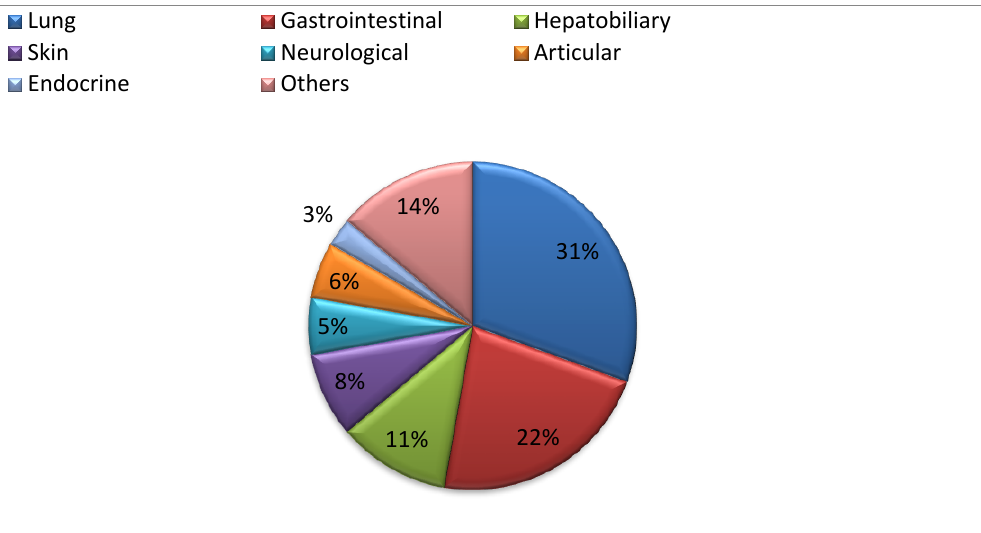
Figure 1. Type and incidence of Grade 3 – 4 irAEs. Grade 3 – 4 irAEs occurring in the series of 201 consecutive patients receiving ICI from 1 January 2016 to 31 December 2019 are summarized in a pie chart, showing that the most prevalent Grade 3 – 4 irAEs are respiratory (31%) and gastrointesti- nal (22%) while endocrine Grade 3 – 4 irAEs are rare (3%), linked to non-thyroid irAEs.